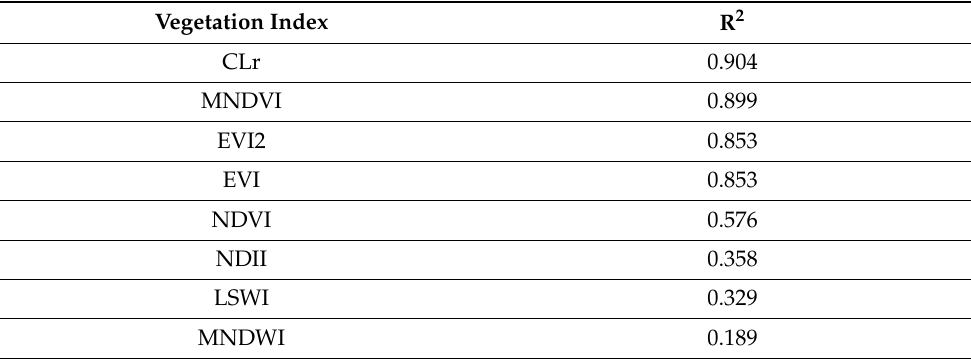
Table 5. Coefficient of determination between different VIs and in situ GPP. Vegetation Index R 2